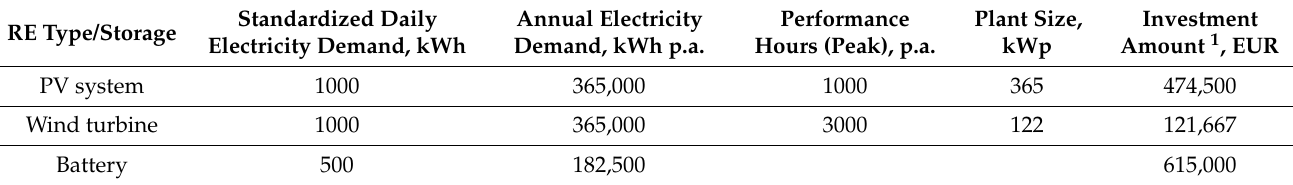
Table 2. Investment requirements to generate 1000 kWh of renewable electricity and store 500 kWh (usable capacity/storage capacity net in kWh) per